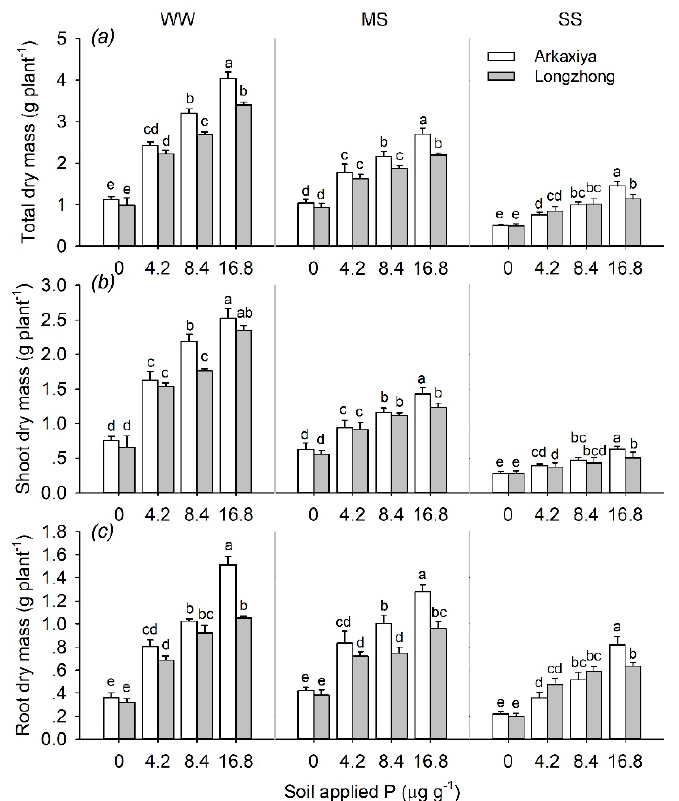
Figure 1. Changes in total dry mass (DM) ( a ), shoot DM ( b ) and root DM ( c ) of two alfalfa genotypes, Arkaxiya (white bars) and Longzhong (grey bars) grown for 10 weeks with four applied P levels and three water treatments: (i) well-watered (WW); (ii) moderate water shortage (MS); and (iii) severe water shortage (SS). Values are means + one standard error of the mean ( n = 3). Different letters between bars represent significant differences between means at p < 0.05.